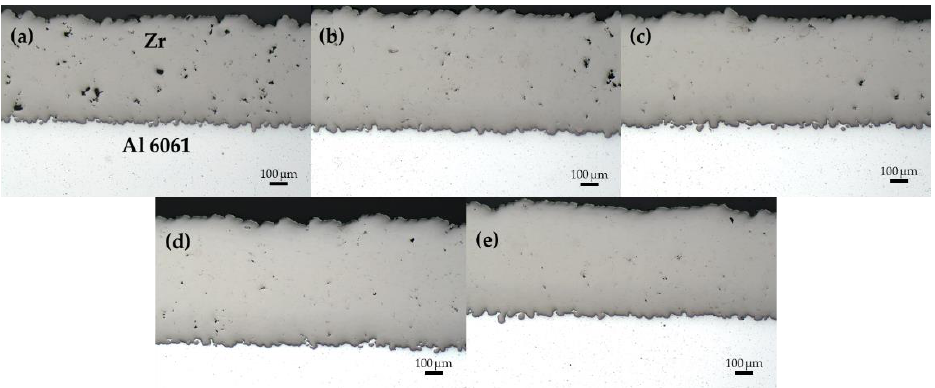
Figure 6. Micrographs of the polished cross-section of non-etched specimens ( a ) S1, ( b ) S2, ( c ) S3, ( d ) S4, and ( e ) S5.